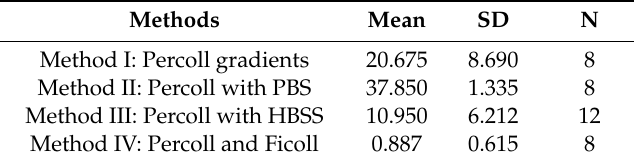
Figure 1. Purity and contaminant analysis of granulocyte isolation comparing the four methods of isolation. ( A ) Images at the end of each isolation method: (i) method I — Percoll with different gradients, (ii) method II — Percoll with phosphate buffer solution (PBS), (iii) method III — Percoll with Hank’s balanced salt solution (HBSS) and (iv) method IV— Percoll and Ficoll. ( B ) Boxplot of the purity of the granulocyte isolation between methods. ( C ) Boxplot of the contamination of granulocyte isolations between methods. Abbreviations Gra: granulocytes. Table 3. Percentage mean contamination (mononuclear) of each method.